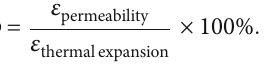
r and temperature under di